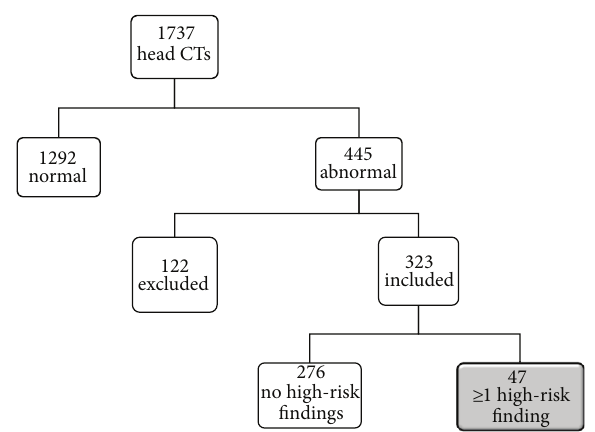
Figure 1: Study subject